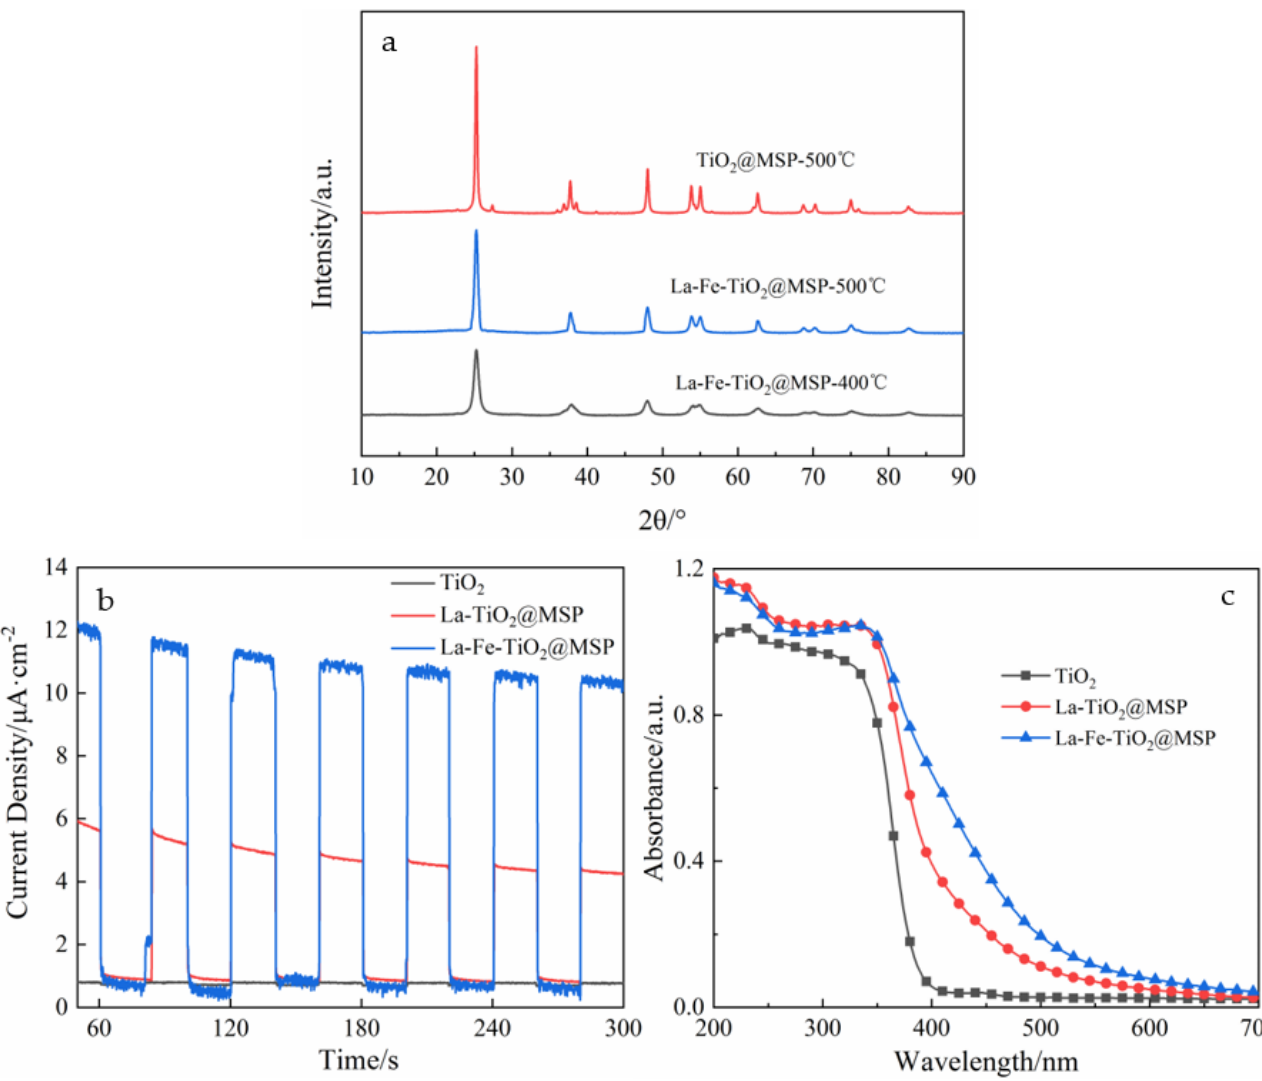
Figure 3. Characterization test charts for different materials: ( a ) XRD patterns of TiO 2 @MSP and La − Fe − TiO 2 @MSP; ( b ) Photoluminescence spectra of TiO 2 , La − TiO 2 @MSP and La − Fe − TiO 2 @MSP; and ( c ) UV − vis di ff use re fl ectance spectra of TiO 2 , La − TiO 2 @MSP and La − Fe − TiO 2 @MSP.